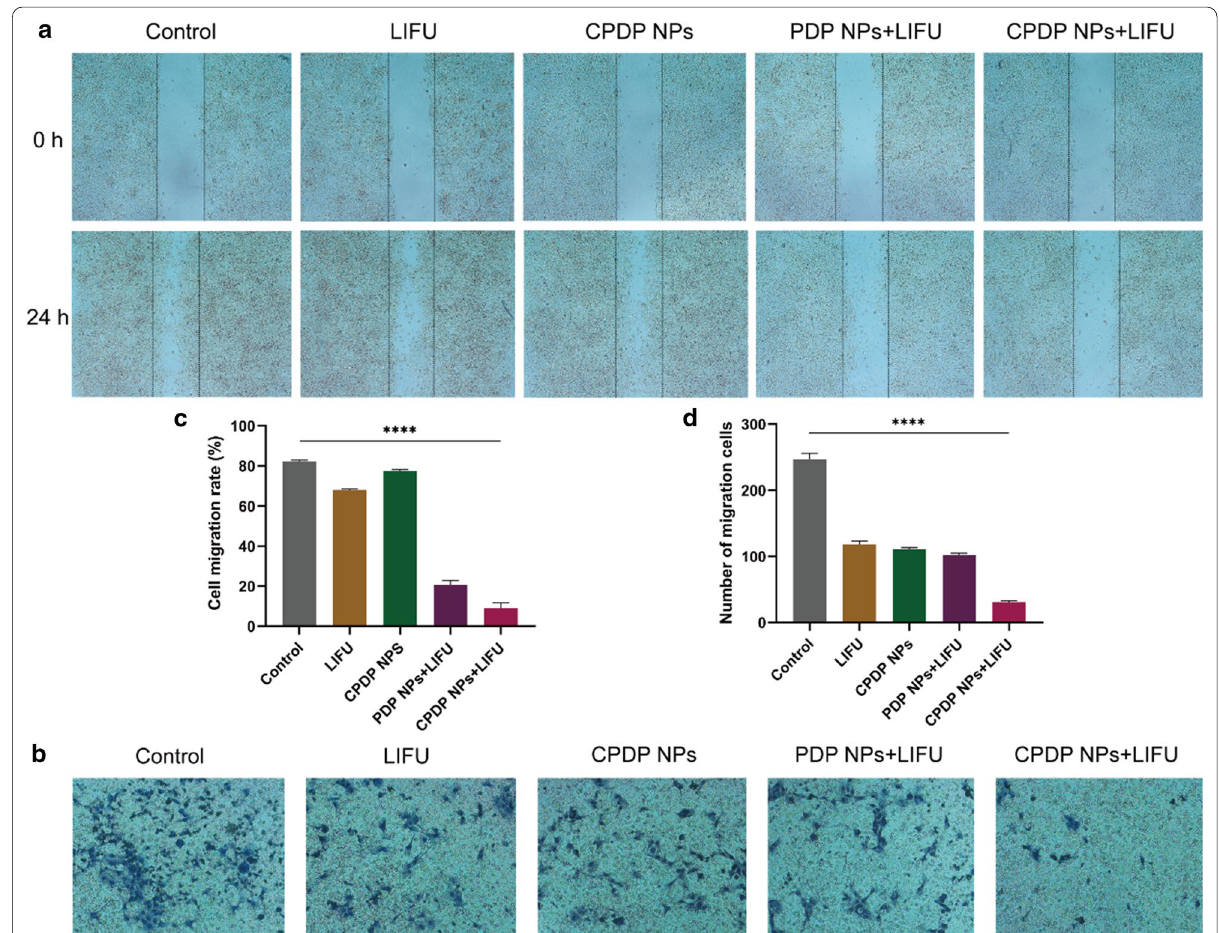
Fig. 6 a The wound healing and b The transwell assay after various treatments. c The corresponding migration rate of wound-healing assay. d The corresponding migration number of tranwell assay (**** p < 0.0001, n